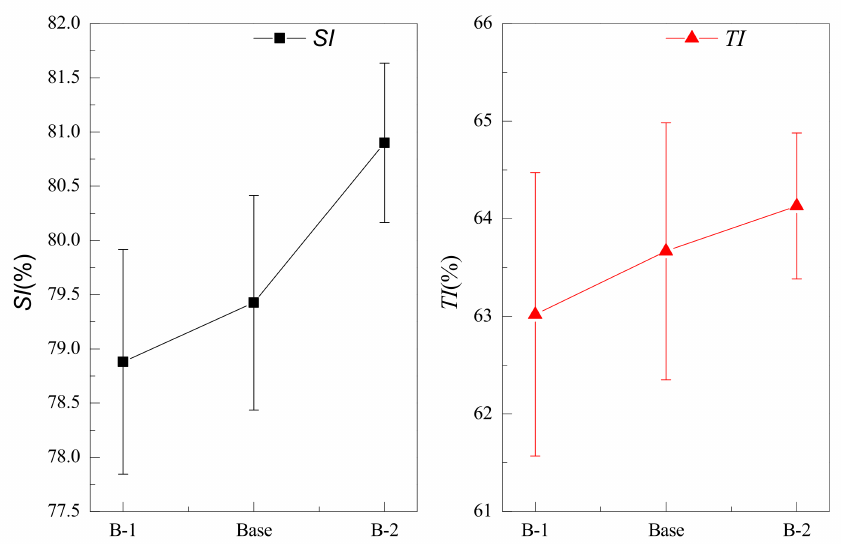
Figure 7. Influences of the CTC ratio in the sintering mixture on sinter quality. (The ratios of CTC: B-1 = 1.8; Base = 2.0; B-2 =